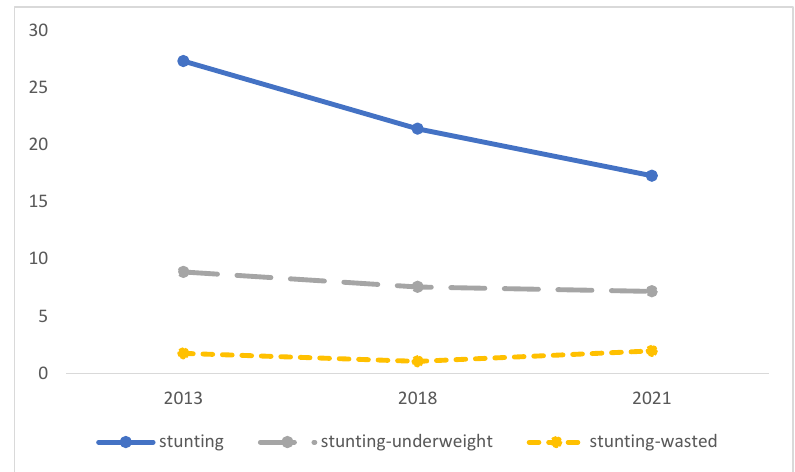
Figure 5. ( A ) Trend of average length/height of male toddlers in Yogyakarta, 2013–2021. ( B ) Trend of average length/height of female toddlers in Yogyakarta, 2013–2021. Although there was a decrease in stunting, the COVID ‐ 19 pandemic contributed to acute malnutrition in the form of stunting ‐ concurrent wasting (Figure 6).